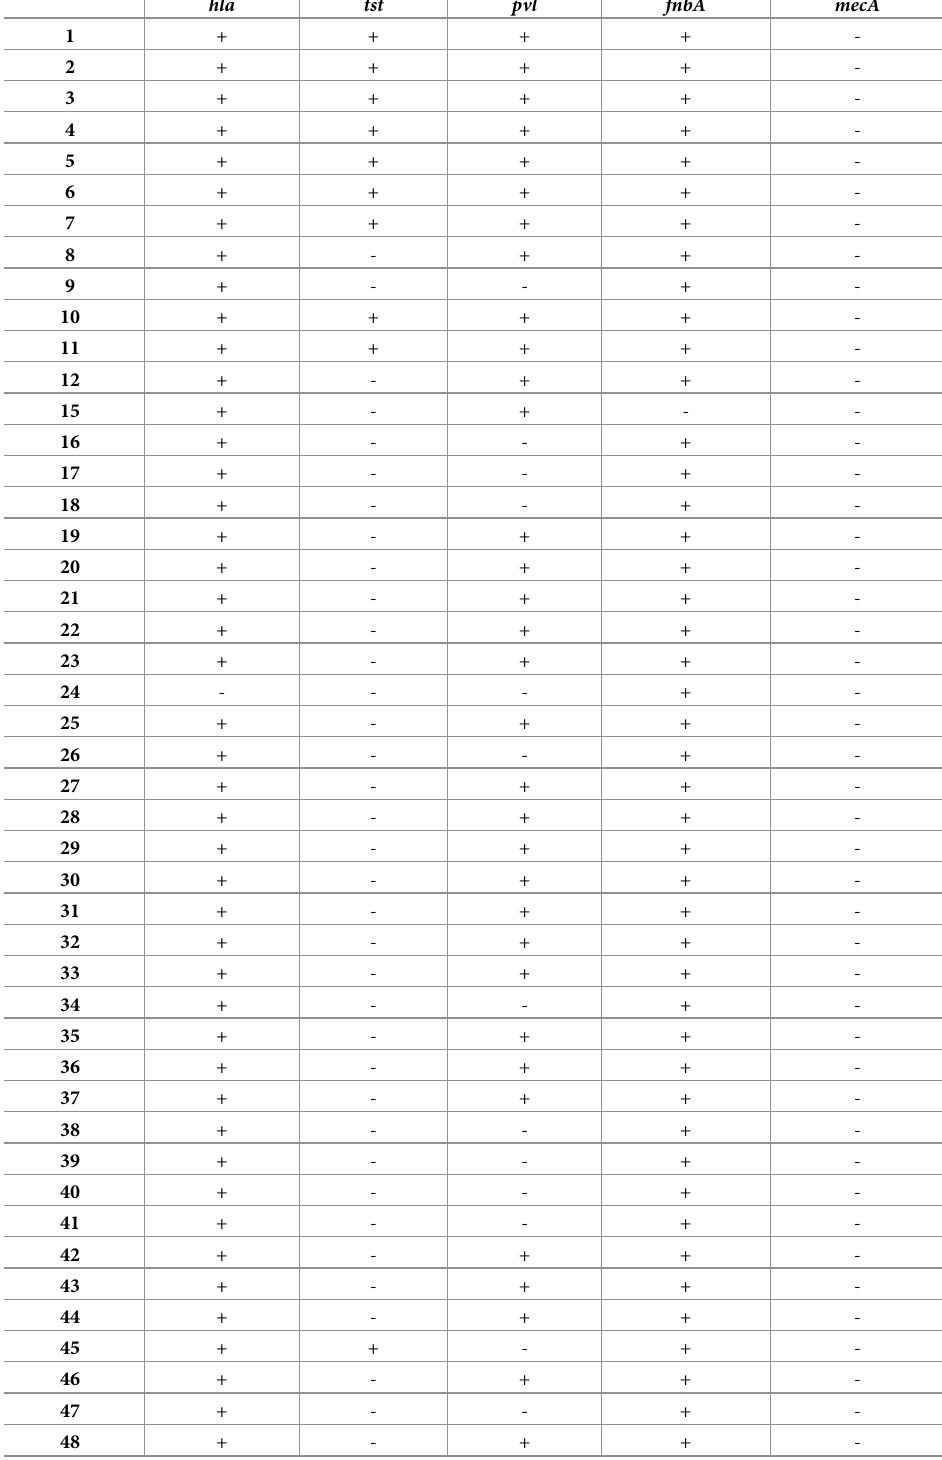
Table 2. Virulence gene detection results. Table shows presence (+) or absence (-) of all virulence genes studied ( hla , tst , pvl , fnbA , mecA ) and for each strain (first